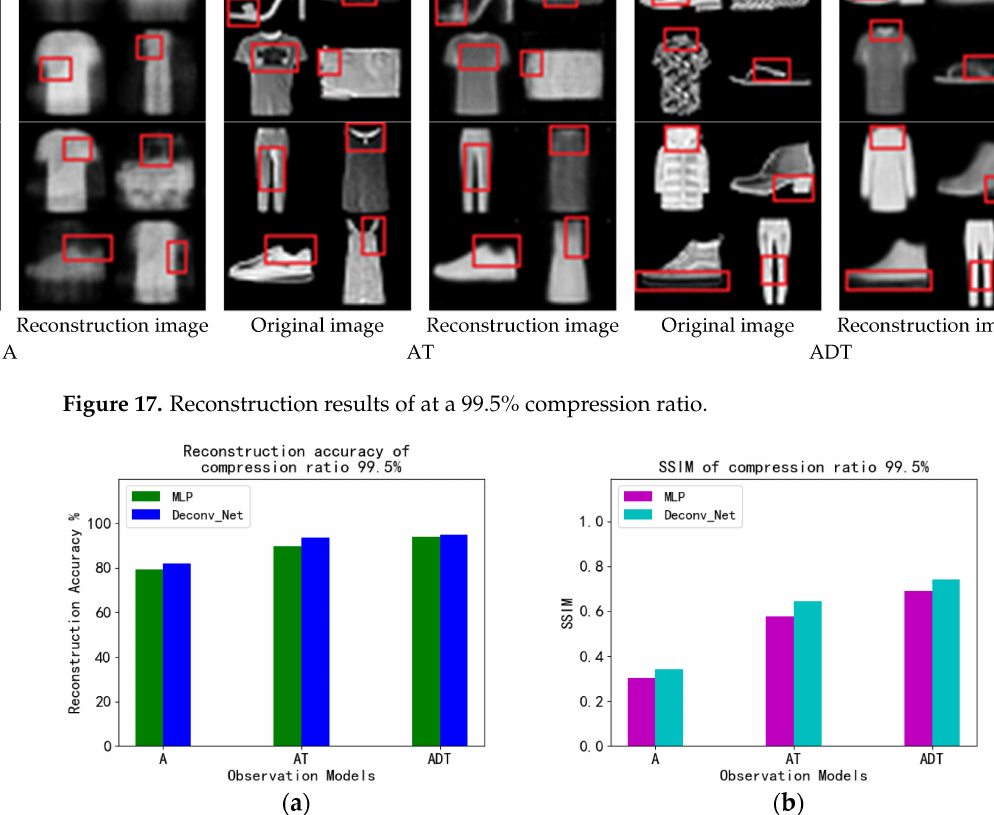
Figure 18. Comparison of reconstruction accuracy ( a ) between MLP and Deconv and SSIM ( b ) at a compression ratio of 99.5%.